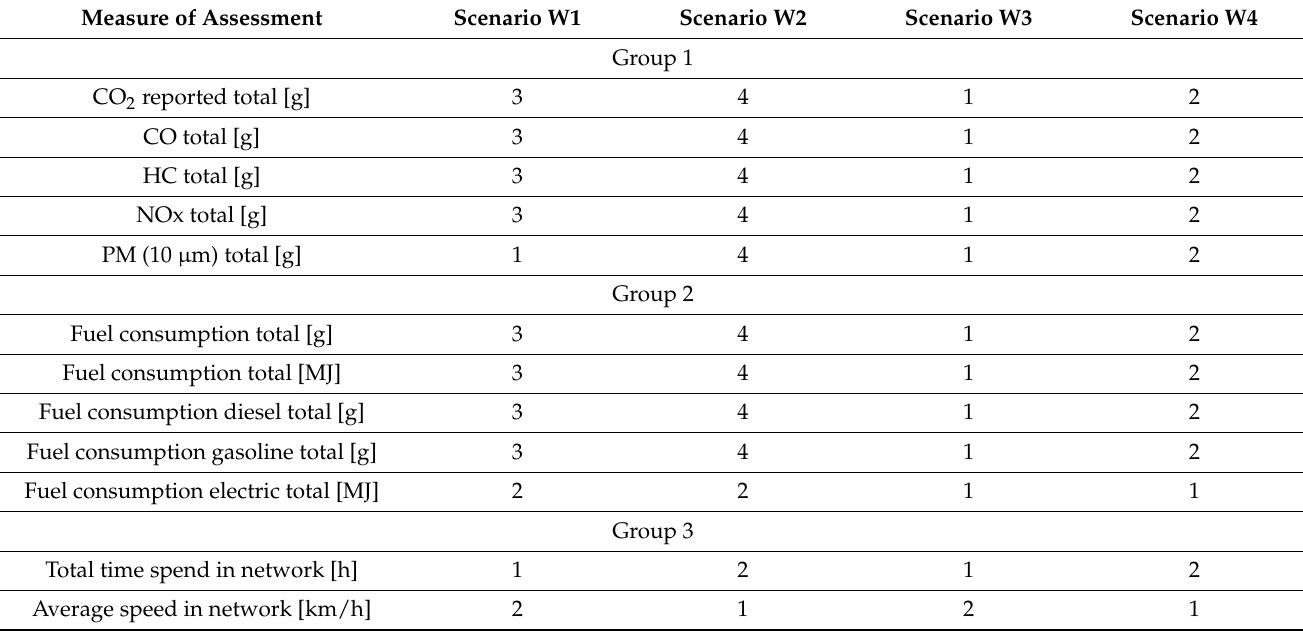
Table 8. Ranking of the scenarios—analysis for the central areas of the city.